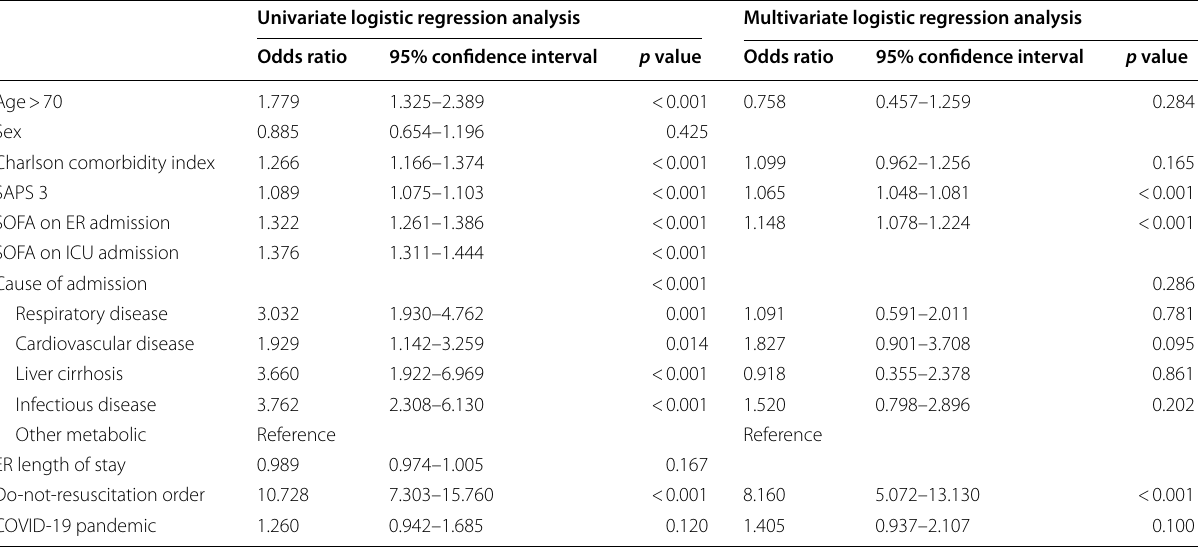
SAPS 3, simplified acute physiology score 3; SOFA, sequential organ failure assessment; ER, emergency room; COVID-19, corona virus disease